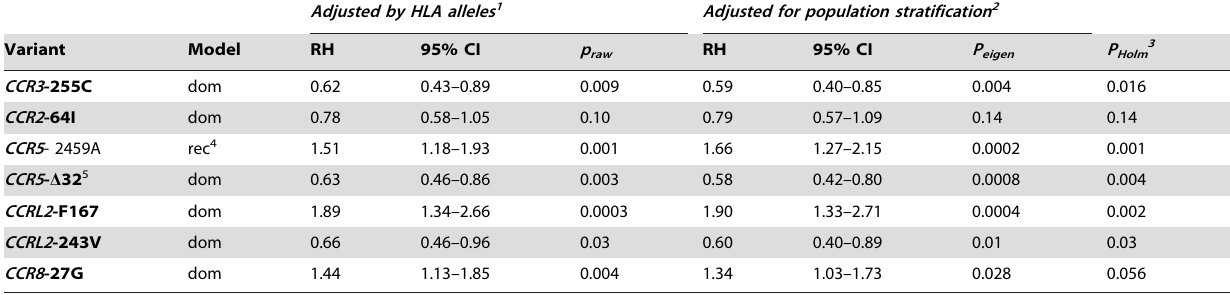
Table 2. Effects of chemokine receptor variants on AIDS